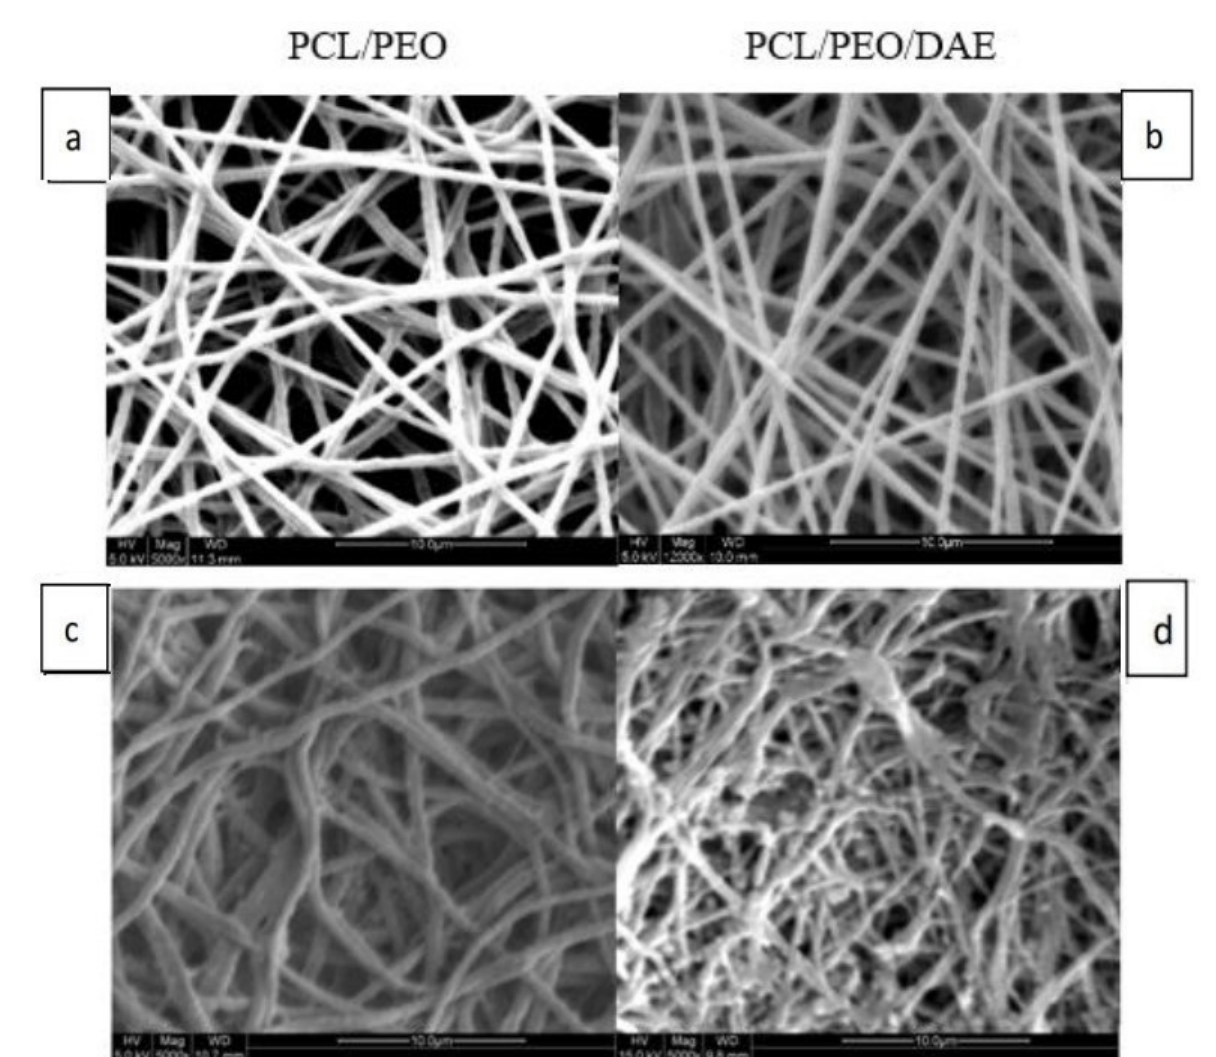
Figure 6. SEM micrograph of PCL/PEO ( a ) and PCL/PEO/DAE nanofibers ( b ); degraded PCL/PEO ( c ) and degraded PCL/PEO/DAE ( d ), scale bar = 10 µm.